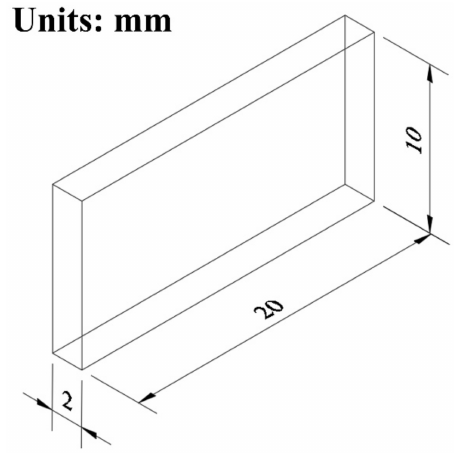
Figure 3. The dimensions of corrosion